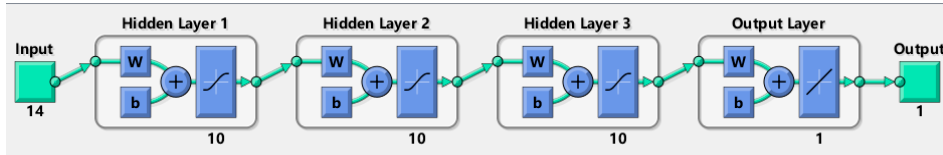
Figure 2. The neural network model constructed in this system.